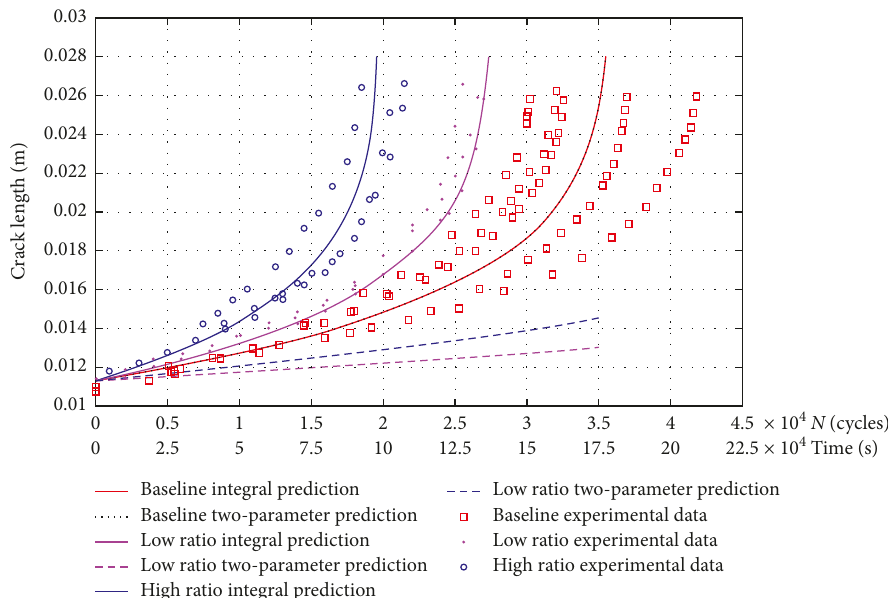
Figure 8: a - N curves for superimposed loading